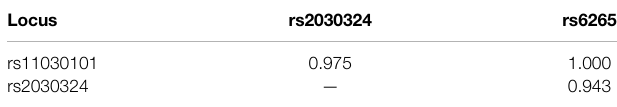
TABLE 7 | Results of linkage disequilibrium analysis. Locus